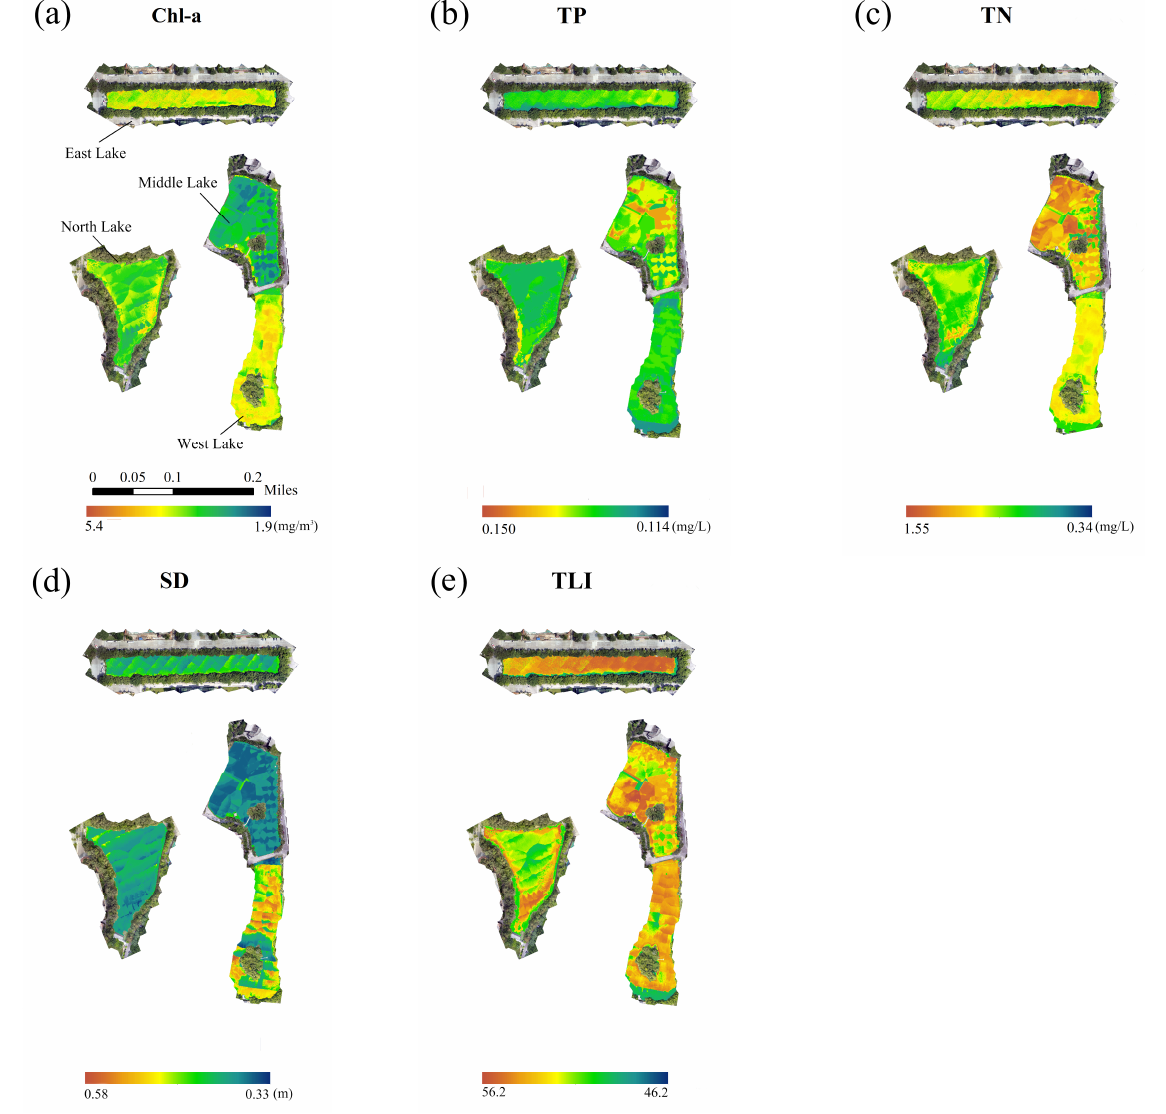
Figure 6. Spatial distribution of different water quality parameters based on the XGB model: ( a ) Chl-a, ( b ) TP, ( c ) TN, ( d ) SD, ( e ) TLI.